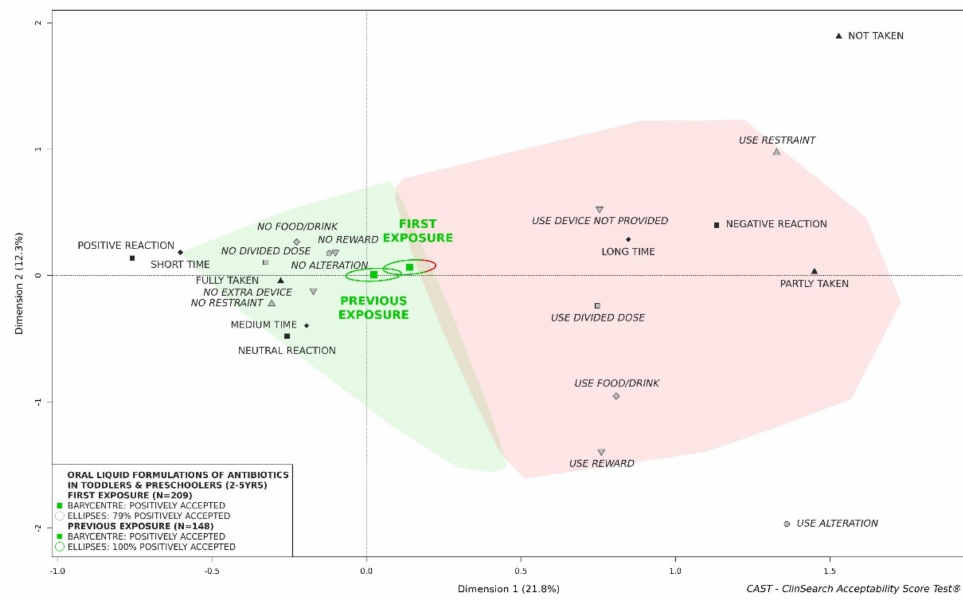
Figure 6. Acceptability of oral liquid formulations of antibiotics in toddlers and preschoolers depend- ing on exposure to